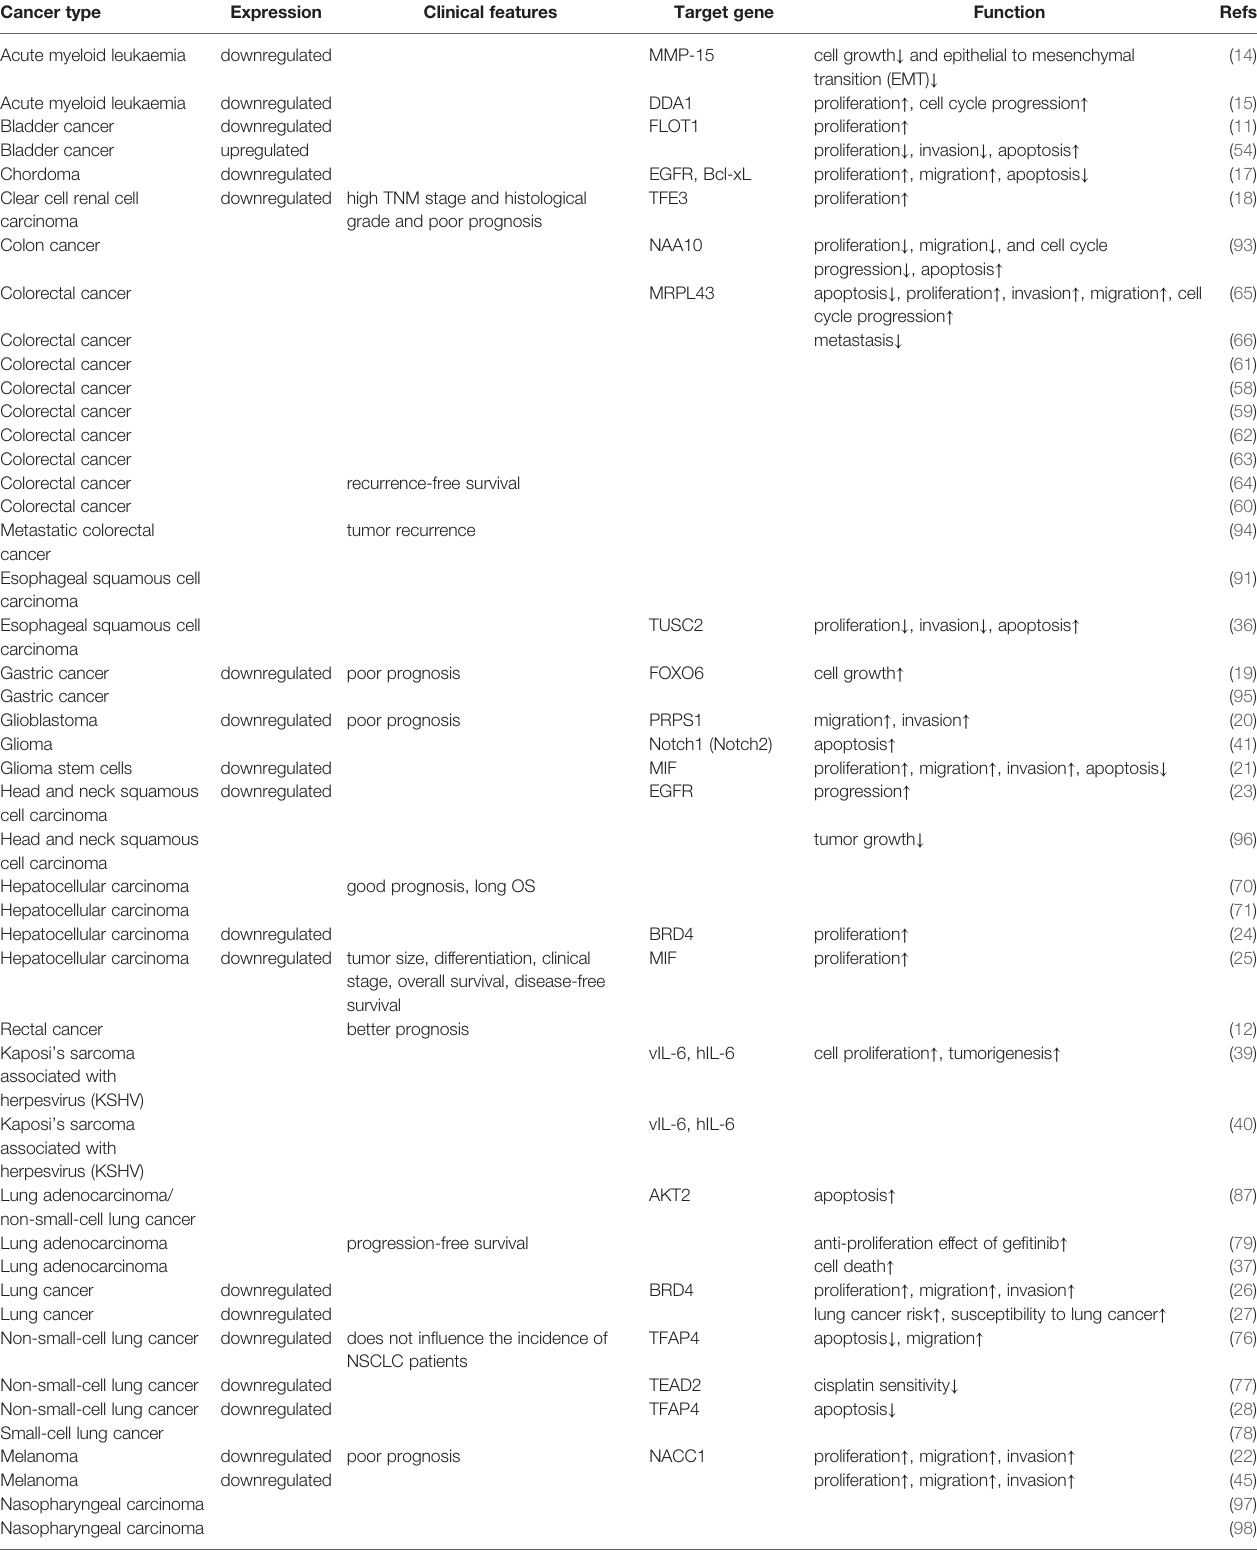
TABLE 2 | The expression pro fi le and biological functions and mechanisms of